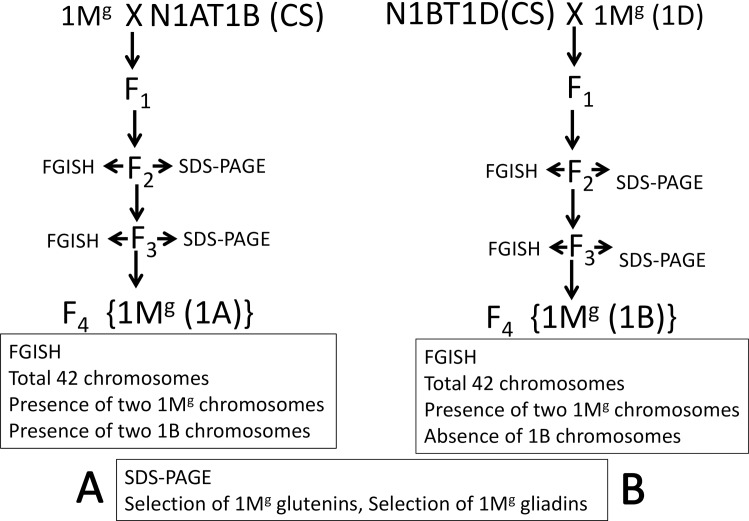
Development of different substitution lines.A- DSL1Mg(1A), B- DSL1Mg(1B). DSLs were prepared by crossing an addition/substitution line with nulli-tetra genetic stock followed by selection using storage protein profile and cytological analysis.